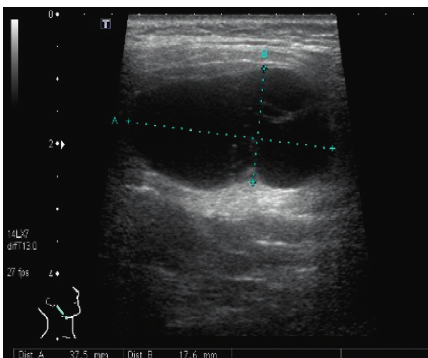
Figure 1: Ultrasonography of the right parotid gland revealed a 37.5 × 17.6 × 24.2mm multilocular cystic lesion with clearly defined margins.